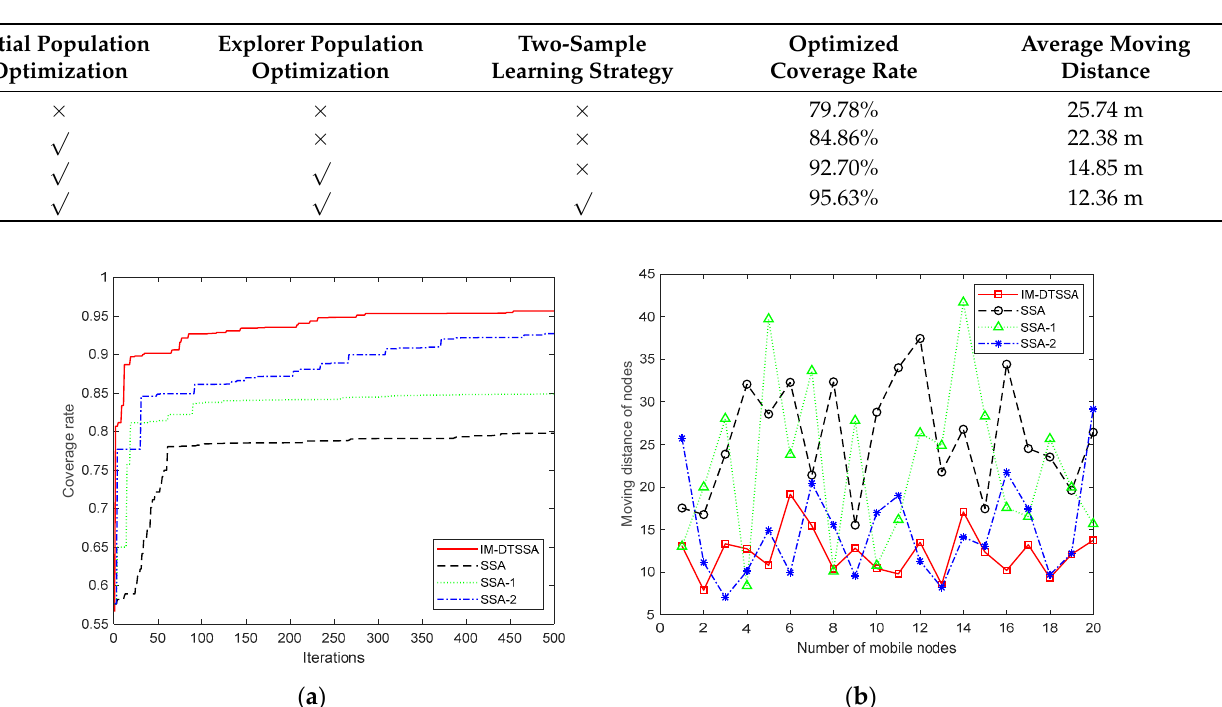
Table 4. Comparison of the effectiveness of the algorithms.